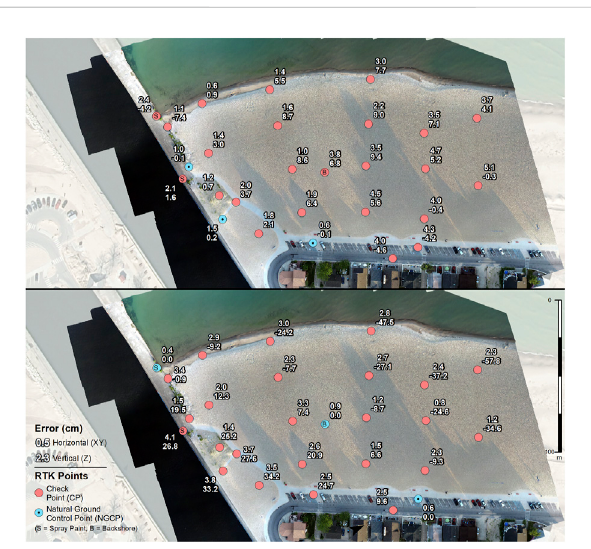
FIGURE 8 Check point (CP) and natural ground control point (NGCP) errors for replications of P-8 using three NGCPs. Top panel shows the distribution of NGCPs that resulted in the lowest CP total RMSE and bottom panel shows the distribution of NGCPs that resulted in the highest CP total RMSE. Red points indicate CP locations and blue points indicate NGCP locations. Spraypainted NGCPs and backshore NGCPs are represented with an “ S ” and “ B ” respectively. Upper point labels show horizontal (XY) error and lower labels show vertical (Z) error in